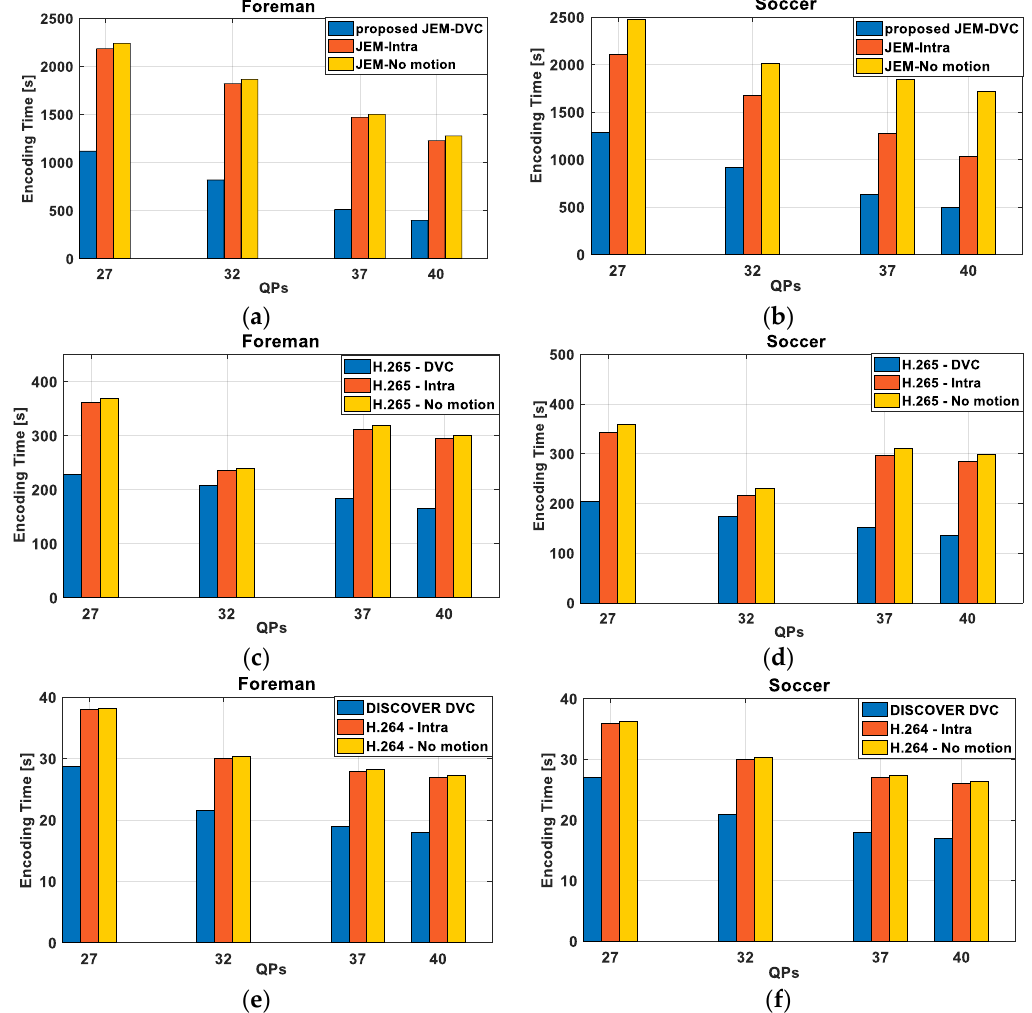
Figure 13. Comparisons of complexity for encoding time (s) obtained by each DVC scheme and video coding standards (Intra and No motion) with different test sequences: ( a–f ) Foreman and Soccer .